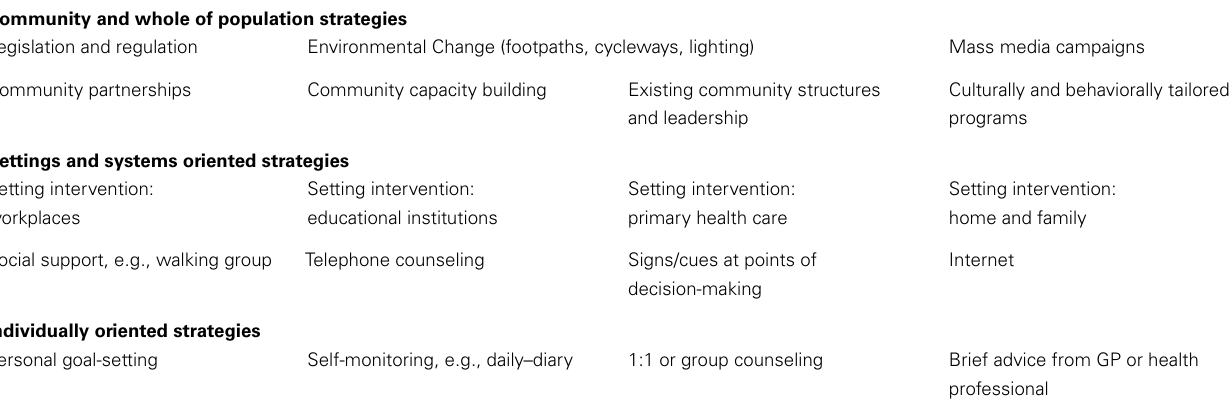
Table 4 | Components of a comprehensive approach to health behavior change [adapted fromWHO European Ministerial Conference on Health Systems (28)]